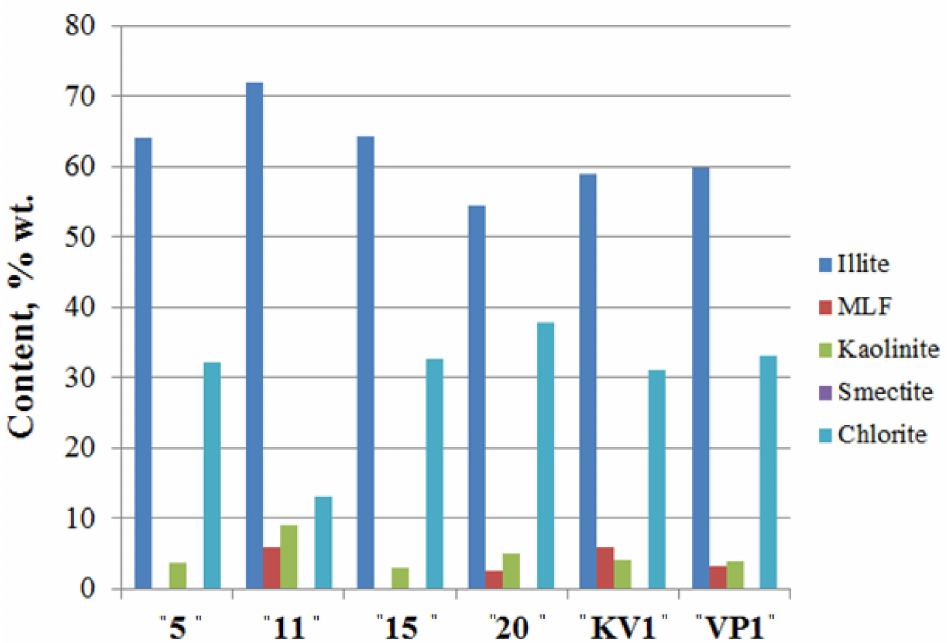
Figure 5. Clay mineral assemblages in the sediments of the Cape Muostakh, the Bykovsky peninsula. I/S is the mixed layered